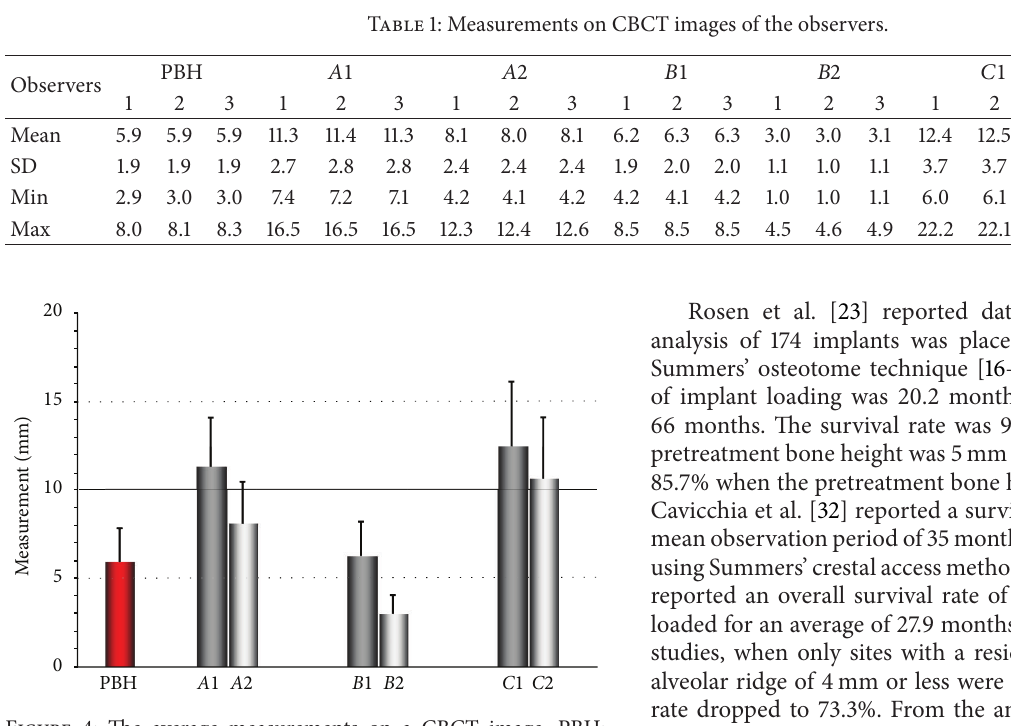
Figure 4: The average measurements on a CBCT image. PBH: preoperative crestal bone height; A : total height of the sinus floor elevation at the first (1) and second (2) operations; B : local height of the sinus floor elevation at the first (1) and second (2) operation; C : width of the sinus floor elevation at the first (1) and second (2)